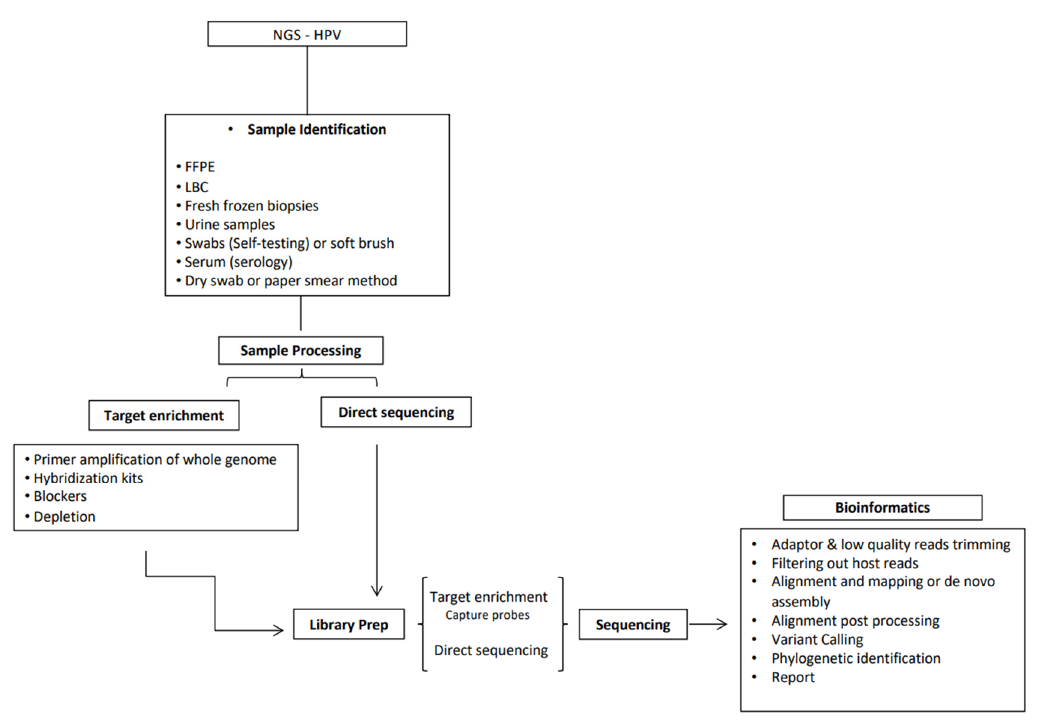
Figure 1. Next-generation sequencing (NGS) for human papillomavirus (HPV) detection and characterization process steps, from sample preparation to data analysis, with focus on whole-genome sequencing (WGS).